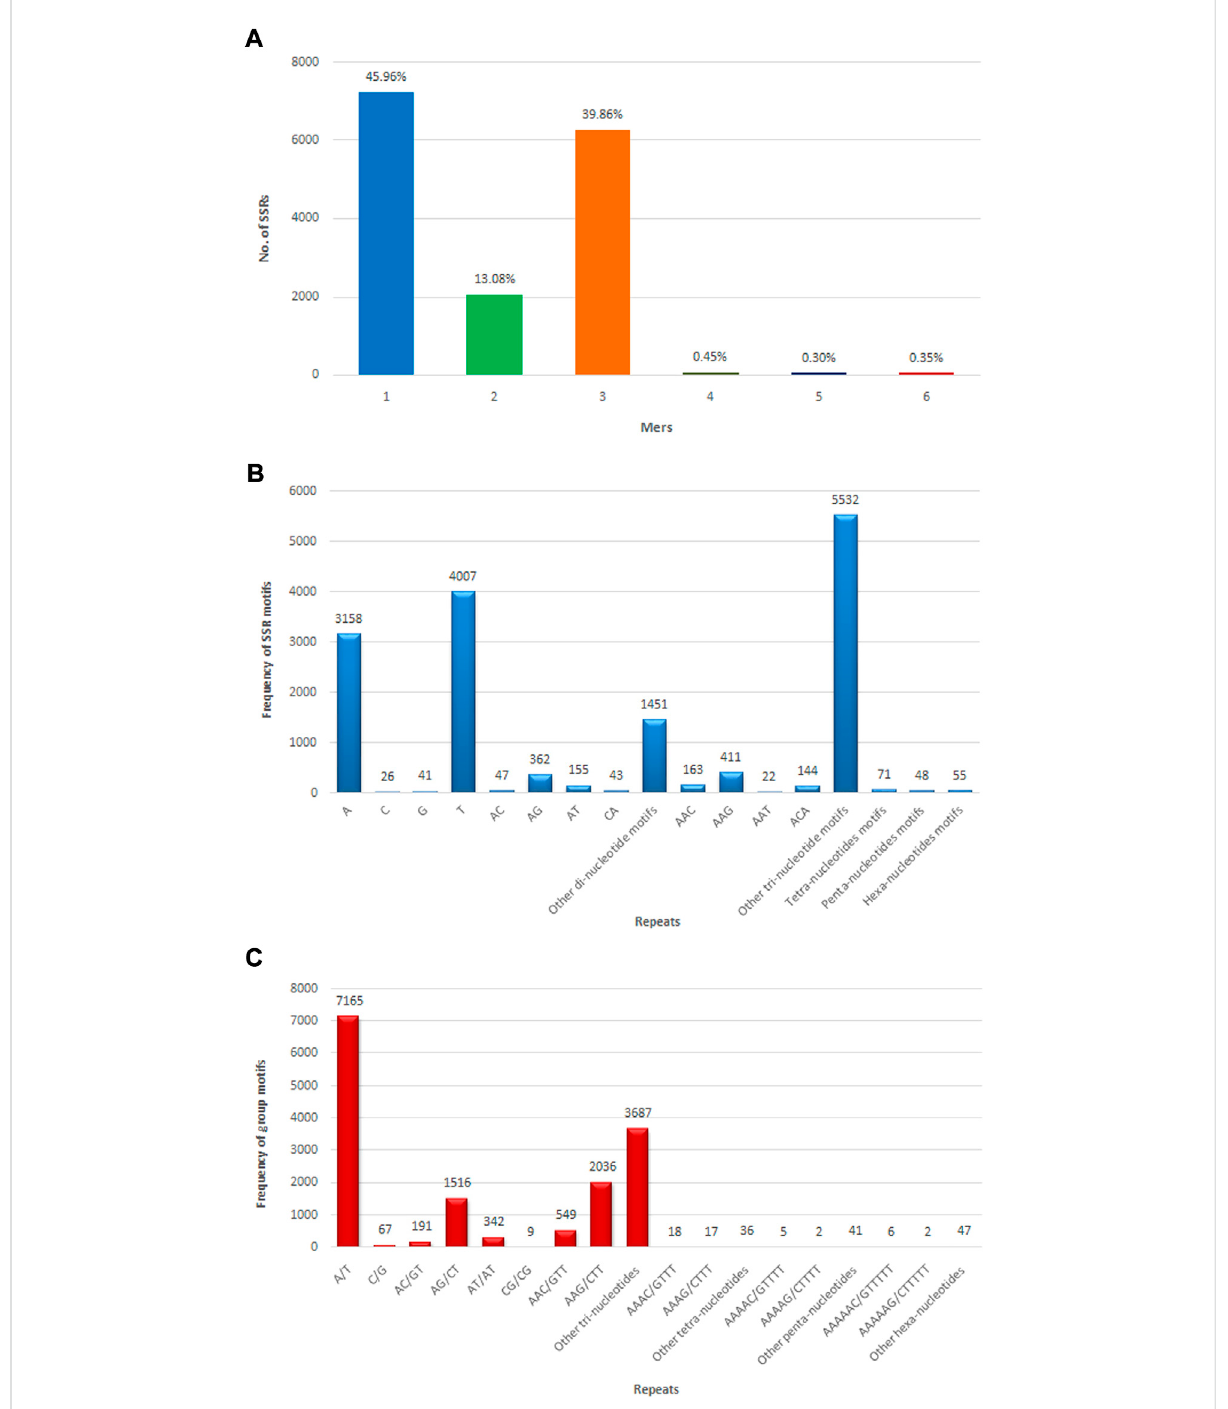
FIGURE 8 Numbers of different types of SSRs identi fi ed in allohexaploid Brassica transcriptomes. (A) Different repeat motif distribution in total SSRs; (B) Top motif distribution in SSRs; (C) Abundance of different grouped repeat motifs in total